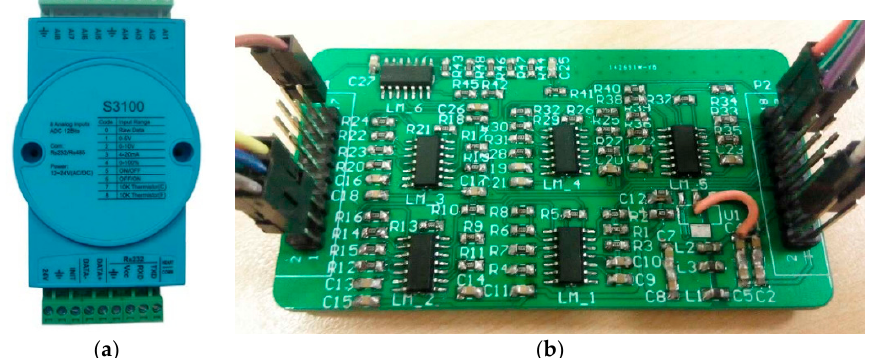
Figure 2. The data acquisition card S3100 and the signal condition circuits; ( a ) data acquisition card; ( a ) electronic board for signal collection.